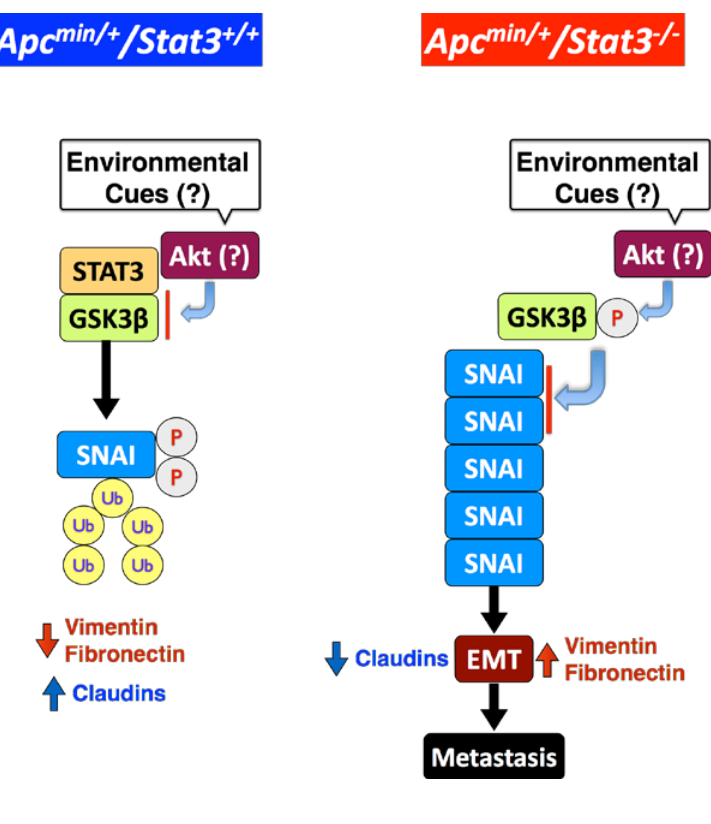
Figure 3. STAT3 suppresses EMT by promoting GSK3β-mediated phosphorylation and proteasomal degradation of SNAI-1 in IEC. STAT3 inhibits phosphorylation of GSK3β (active), which phosphorylates SNAI-1, leading to ubiquitination and degradation. Consequently, epithelial cell markers, such as claudins, are upregulated and mesenchymal markers, such as vimentin and fibronectin, are down-regulated. When STAT3 is deleted from IEC, unknown environmental cue(s) induce phosphorylation of GSK3β (inactive), most likely via the Akt pathway, leading to accumulation of SNAI and